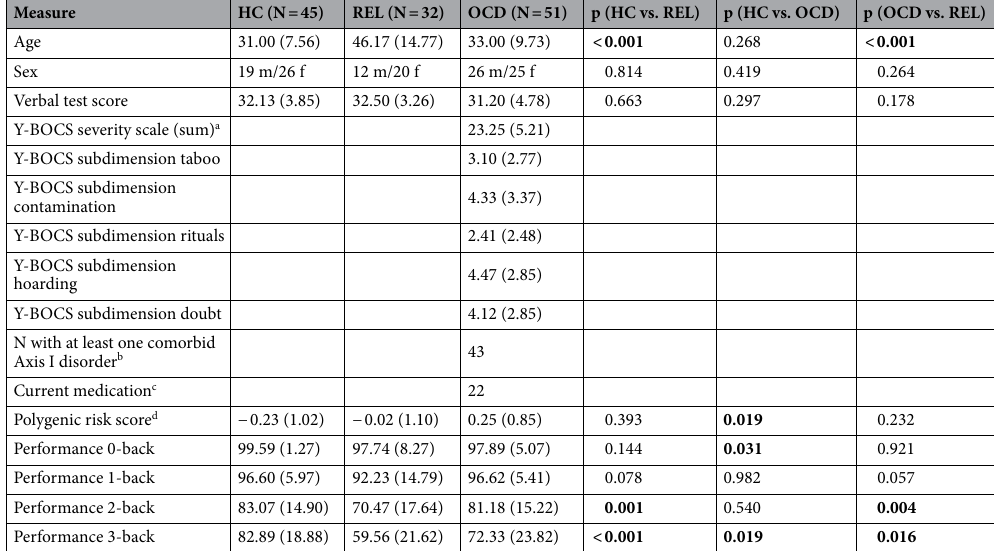
Table 1. Demographics of HC (HC), patients with obsessive-compulsive disorder (OCD), and unaffected first-degree relatives of OCD patients (REL). Means and standard deviations (in parentheses) are shown. Reported p-values are derived from two-sample t tests or a χ 2 -test (for the variable sex). P-values with bold emphasis indicate significant differences at p < 0.05. Units: Age [years]; Verbal test score [sum score]; Y-BOCS [sum score]; Polygenic risk score [z-transformed values]; Performance [% correct], (see estimated marginal means from ANCOVA model with covariate age in Fig. 1). a Subdimensions of Y-BOCS according to Katerberg et al. 57 . b Comorbid mental disorders in OCD patients: 27 OCD patients had one comorbid mental disorder, 16 had two or more, and 8 had no comorbid mental disorder. In total, 44 mood disorders (23 currently remitted), 15 anxiety disorders, 3 eating disorders, 2 somatoform disorder, 1 tic disorder, 1 cannabis abuse were diagnosed. c 19 SSRIs, 4 SSNRIs, 5 tricyclic antidepressants, 2 neuroleptics, 1 benzodiazepine. d In our fMRI sample, polygenic risk score was available in 43 HC, 32 REL, and 44